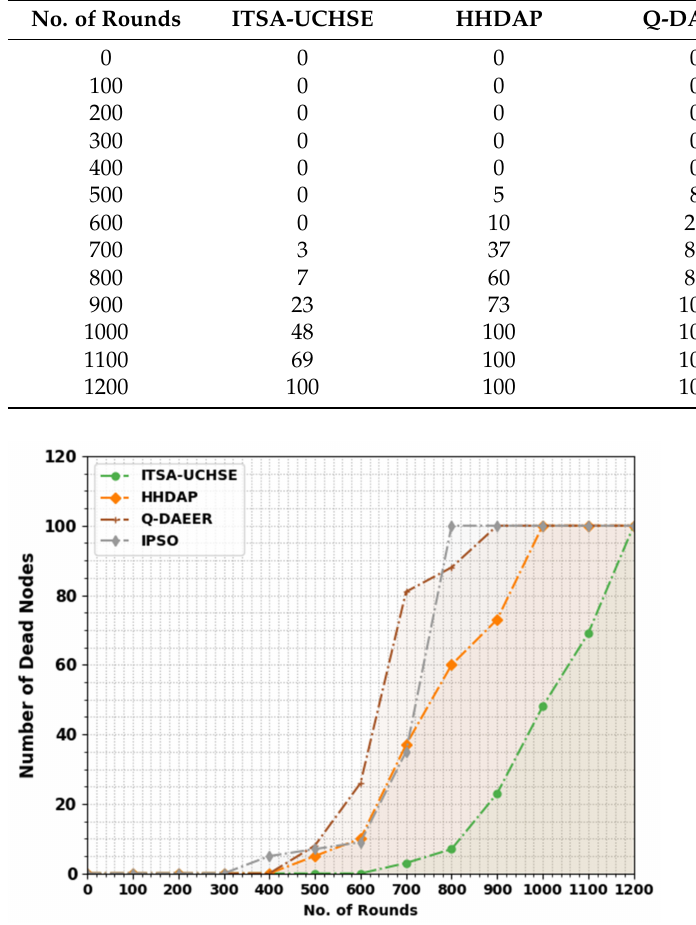
Figure 4. NODN analysis of ITSA-UCHSE system under distinct